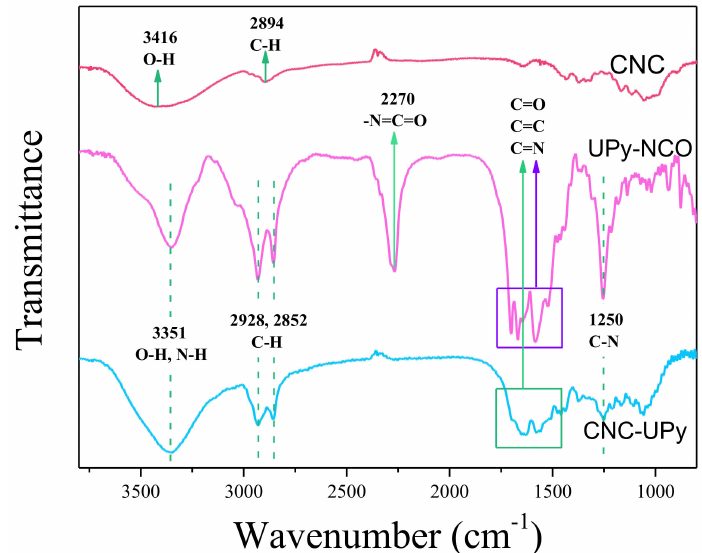
Figure 1. ATR-FTIR spectra of CNC, UPy-NCO and